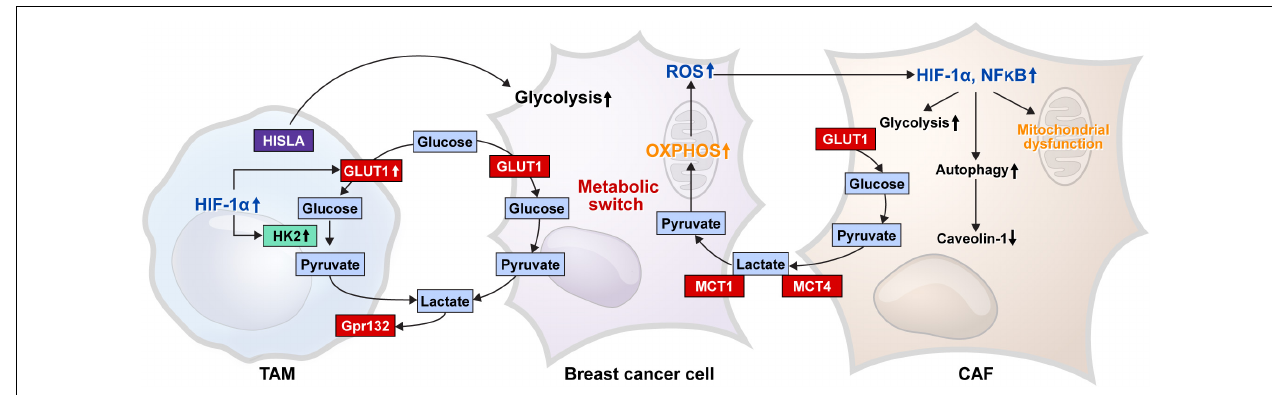
FIGURE 3 | Glucose metabolic interaction between breast cancer cells and stromal cells. The glucose metabolic interaction between the breast cancer cell and CAF is presented as the reverse Warburg effect, where mitochondrial dysfunction results in a decrease in caveolin-1 levels because of increased autophagy, and an increase in glycolysis occurs by enhanced HIF-1 α and NF- κ B in CAF. Lactate produced by glycolysis is transferred to cancer cells by MCT4 in CAF and MCT1 in cancer cells, which is converted to pyruvate and used as a material for mitochondrial OXPHOS. ROS produced by the OXPHOS process cause an increase in HIF-1 α and NF- κ B in CAF. TAM, one of the immune cells of breast cancer stroma, shows increased glycolysis because of the increased GLUT1 and HK2 activity by enhanced HIF-1 α expression; therefore, TAM can compete with cancer cells for glucose. G protein-coupled receptor 132 (Gpr132) senses the lactate produced by glycolysis to convert the macrophage to an M2-like phenotype, which promotes cancer cell adaptation, migration, and invasion. HIF-1 α -stabilizing long non-coding RNA (HISLA) is transferred from TAM to breast cancer cells through extracellular vesicle transmission, and then, HISLA promotes glycolysis in breast cancer cells. Breast cancer cells have a metabolic switch that controls glycolysis and OXPHOS depending on the circumstances. CAF, cancer-associated fibroblast; HIF, hypoxia-inducible factor; MCT, monocarboxylate transporter; OXPHOS, oxidative phosphorylation; HK, hexokinase; ROS, reactive oxygen species; TAM, tumor-associated